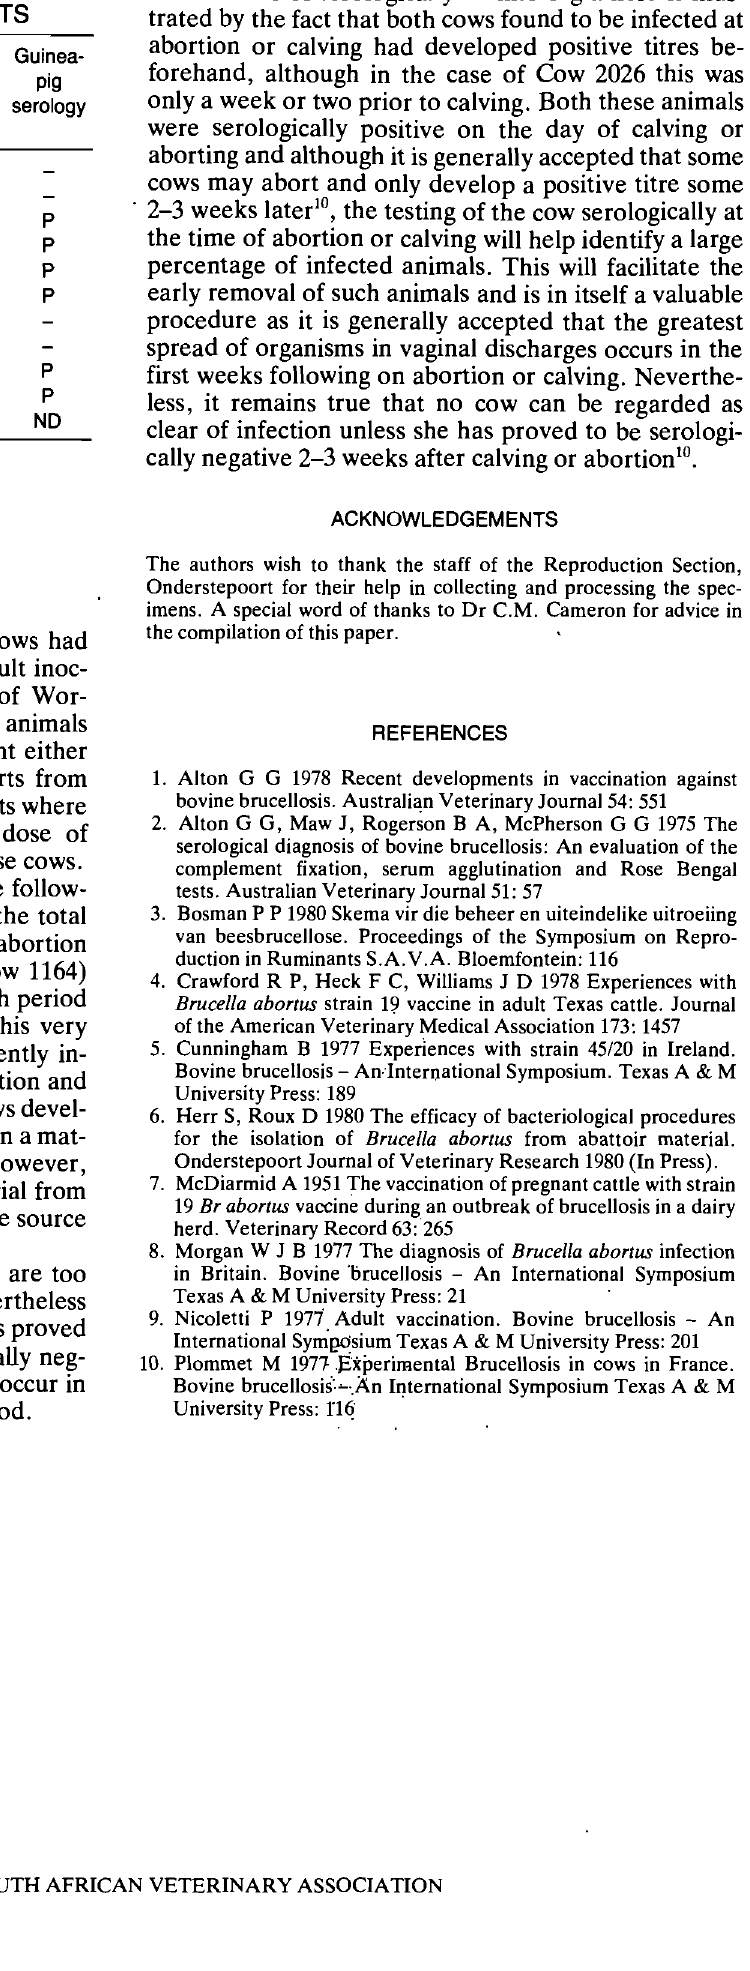
Table 7: CORRELATION OF SEROLOGICAL DIAGNOSIS WITH ISOLATION